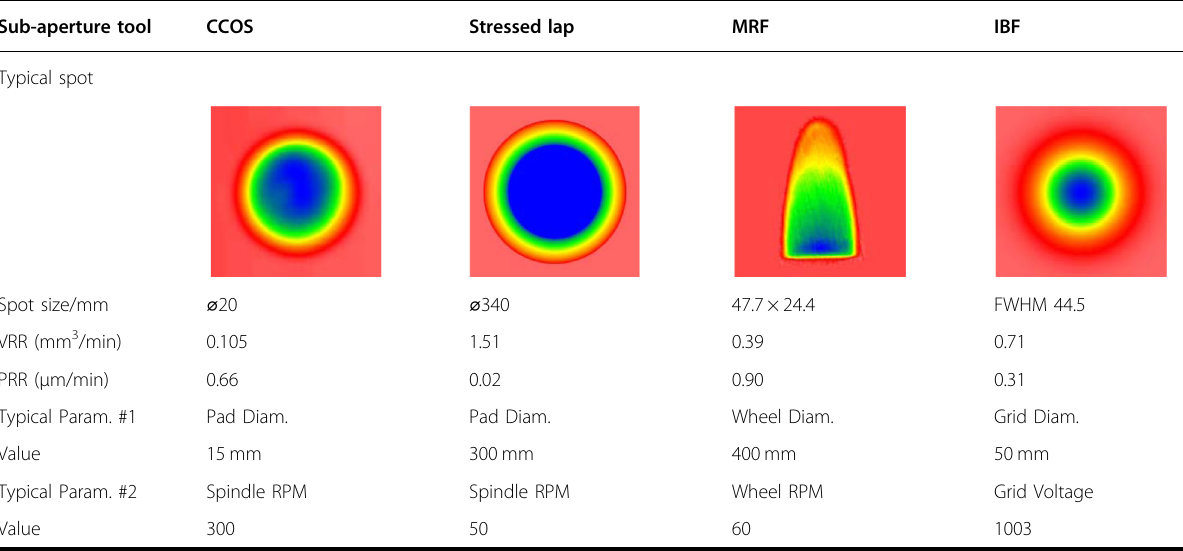
Table 4 Material removal of sub-aperture tool on PVD Si-cladding RB-SiC substrate Sub-aperture tool